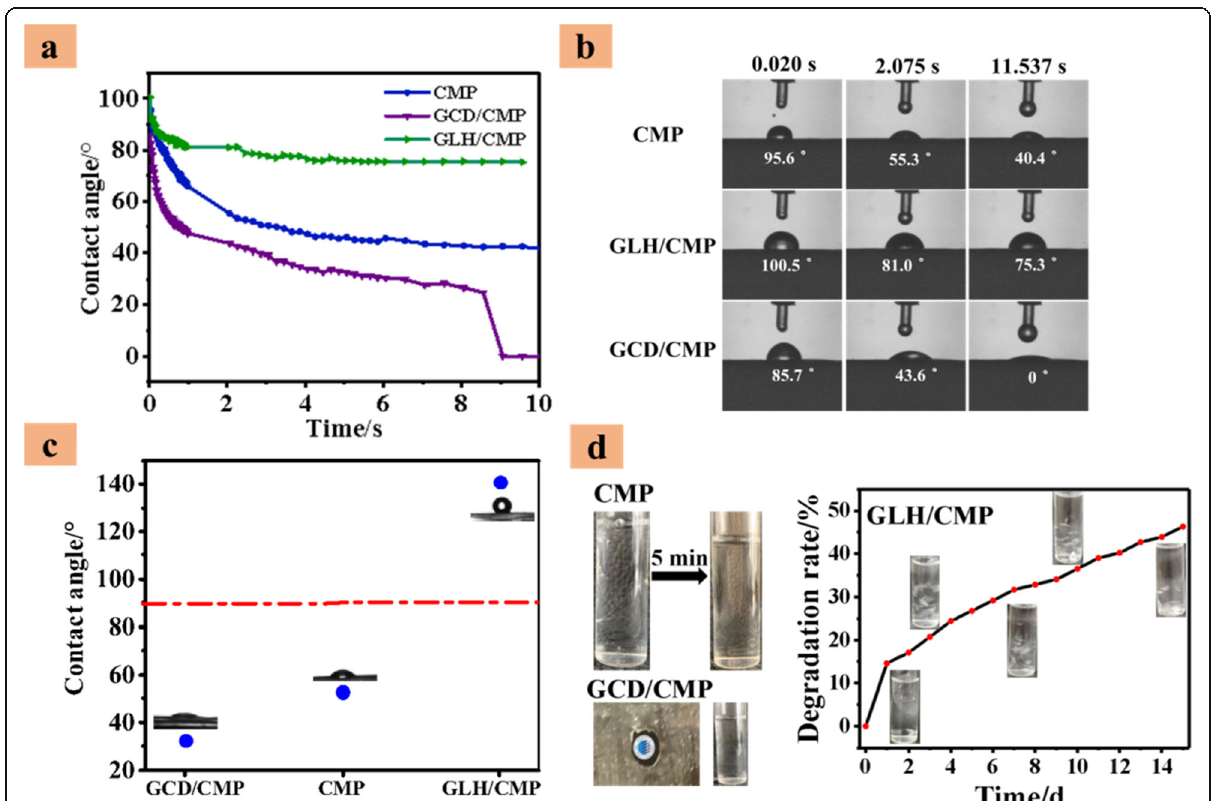
Fig. 5 a Contact Angle and time relationship; b The DCA diagram; c The SCA image; d Degradation of CMP, GCD/CMP and